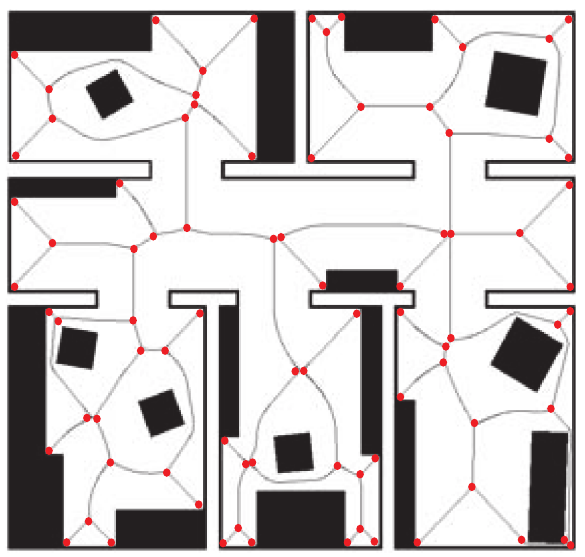
Figure 5: A generalized Voronoi diagram of an indoor space